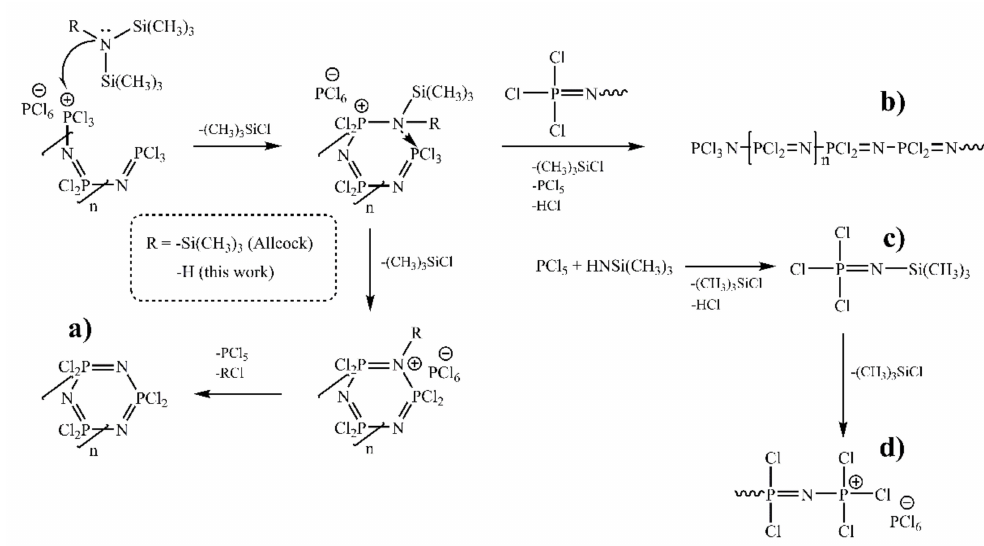
Figure 3. The formation of various-sized cyclophosphazenes via short-chain linear